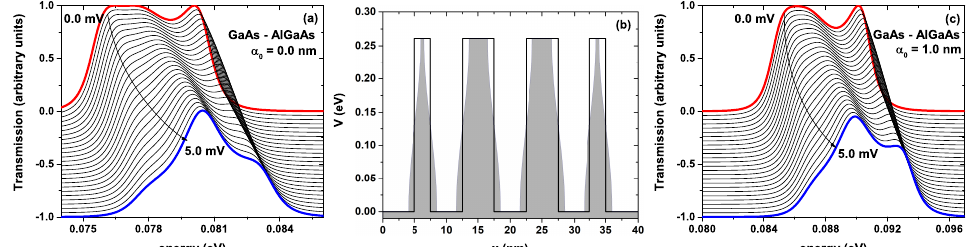
Figure 7. Corresponds to the system shown in Figure 2(c3). ( a ) the transmission probability for the GaAs-Al 0.3 Ga 0.7 As lattice without laser effect for different bias voltages concerning the incident electron energy; ( b ) the scheme of the potential profile for the barrier-well lattice system; the black curve corresponds to the system without laser effect and the shaded region including an ILF parameter strength of α 0 = 1.0nm; ( c ) the same as in ( a ), but with an ILF effect, α 0 = 1.0nm. The width of the wells and the two central barriers have been set at 5nm and the two lateral barriers at